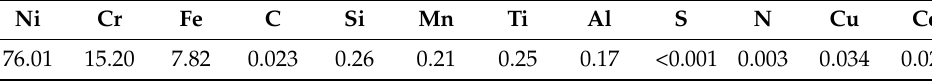
Table 1. Chemical composition of Alloy 600 (wt.%).